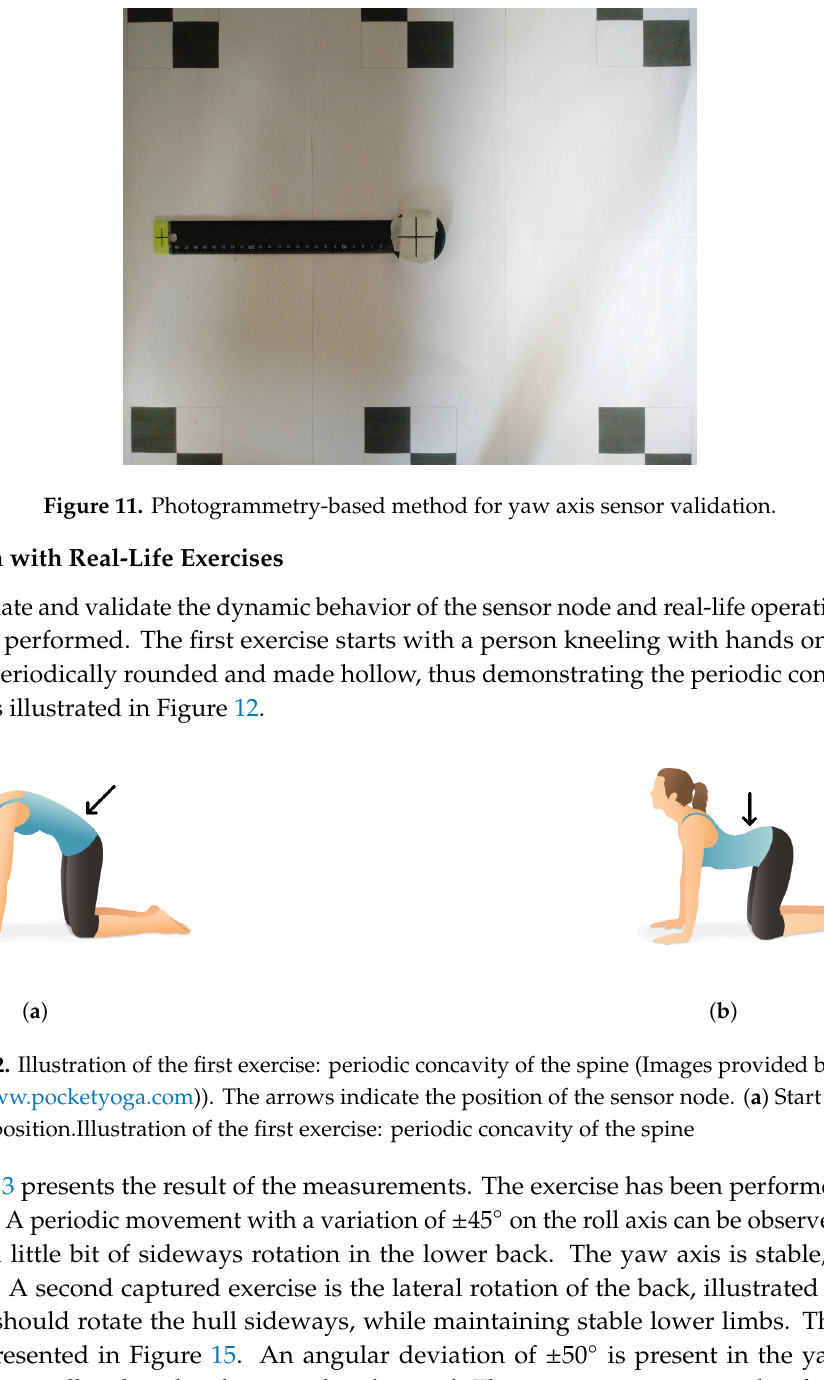
Roll Pitch Yaw Number of samples Figure 13. Exercise: Rounded back—hollow back. A periodic movement with a variation of ± 45° on the roll axis can be observed. The pitch and yaw axis are stable.